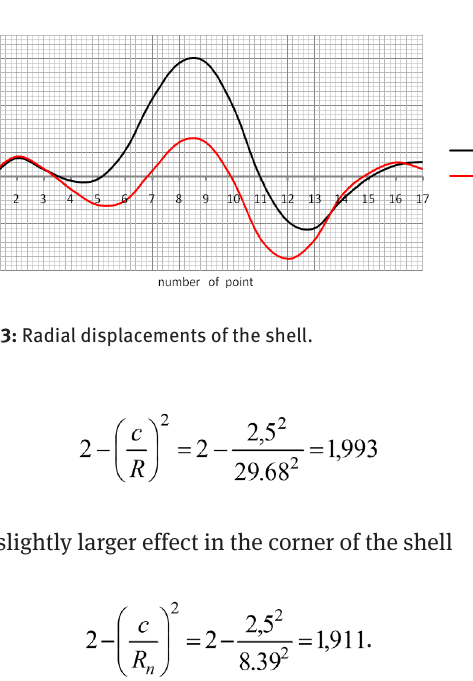
Figure 14 compares the bending moment diagrams, which were calculated from equation (27) based on displacements and relationships in equation (2), with the bending moments obtained based on strain gauge in the shape and ordinate values of these diagrams.